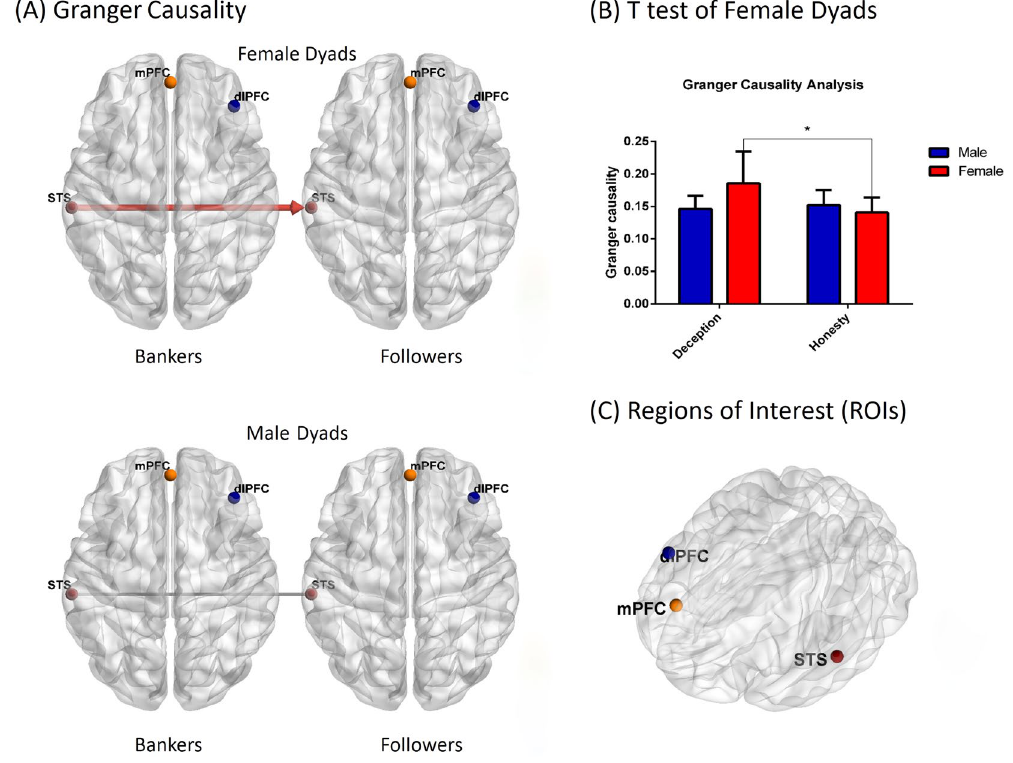
Figure 5. Directional coupling in female and male dyads. ( A ) The G-causality was analyzed in two directions (from bankers to followers, from followers to bankers). Direction was indicated by arrow and Significant G-causality was indicated by a red solid-line ( * P < 0.05, FDR corrected) ( B ) Mean G-causalities in two conditions and two genders illustrated in the bar graphs. Only in female dyads, the mean causality from bankers to followers (indicated by red color) was significantly higher in the deception conditions than in the honesty conditions ( * P < 0.05). Error bars indicate standard errors (FDR corrected). ( C ) Regions of interest in this research. mPFC, medial prefrontal cortex; dlPFC, dorsolateral prefrontal cortex; STS, superior temporal sulcus. [All 3-D brain figure was edited based on BrainNet Viewer (Xia,